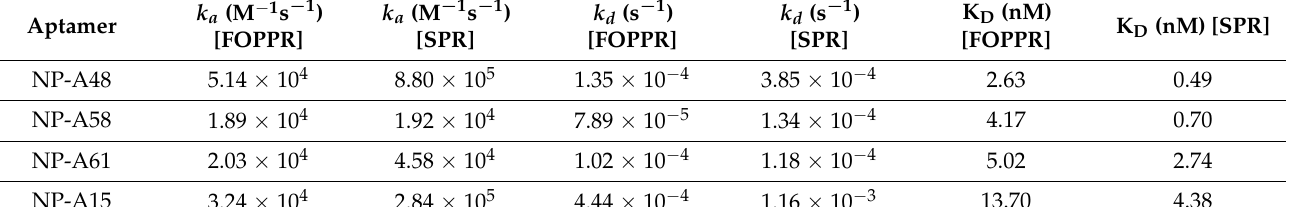
Table 3. Comparison of association rate constant ( k a ), dissociation rate constant ( k d ), equilibrium dissociation constant (K D ) for the binding between each of the four different ssDNA aptamers and the N-protein measured by FOPPR biosensor and SPR biosensor [49].